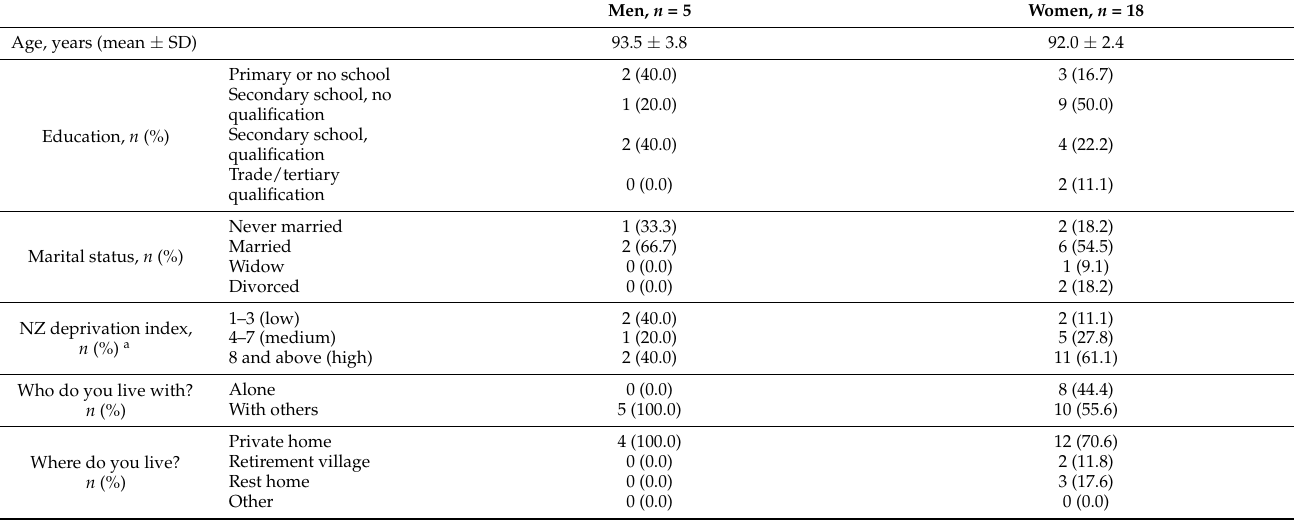
Table 1. Demographic Characteristics, Physical Function and Nutrient Intake in M¯aori